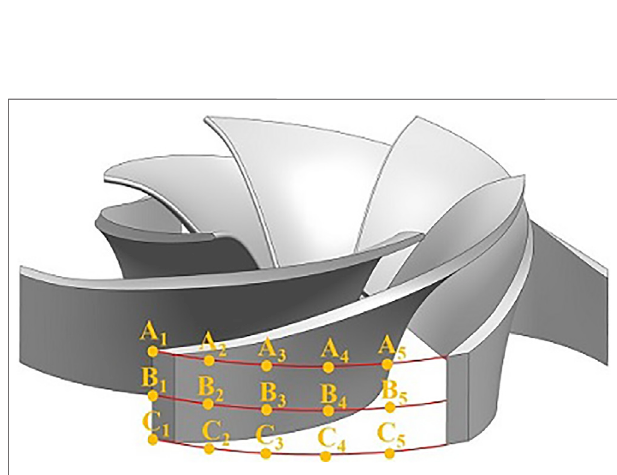
FIGURE 6 | The location diagram of the pressure monitoring